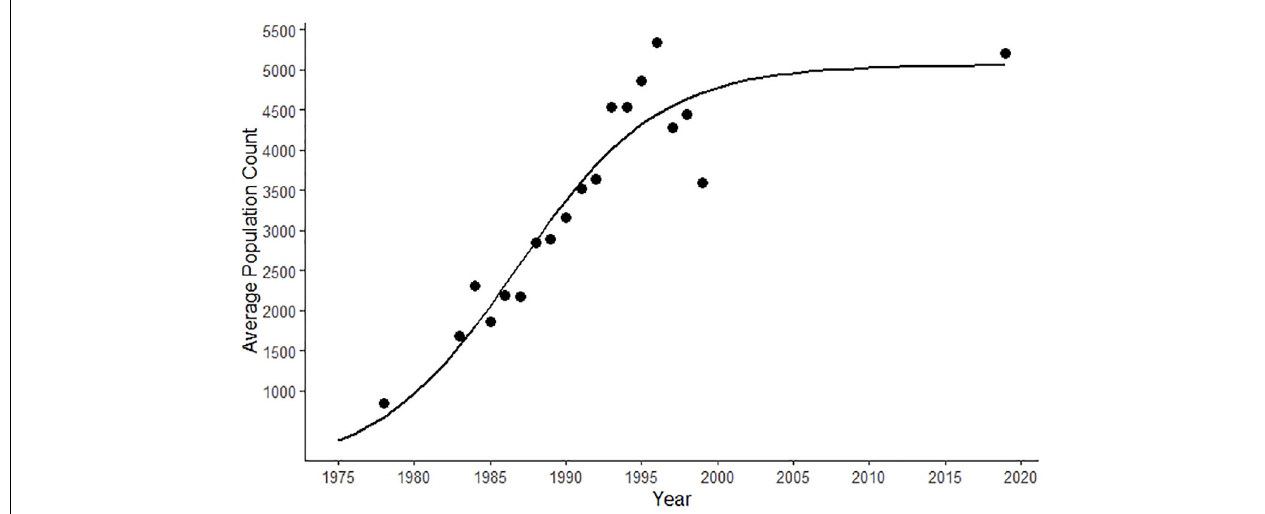
FIGURE 1 | Logistic growth curve of the harbor seal population in the San Juan Islands (i.e., San Juan County) generated using population counts from aerial surveys conducted between 1970 and 2019 (Jeffries et al., 2003; S. Jeffries, unpublished data).